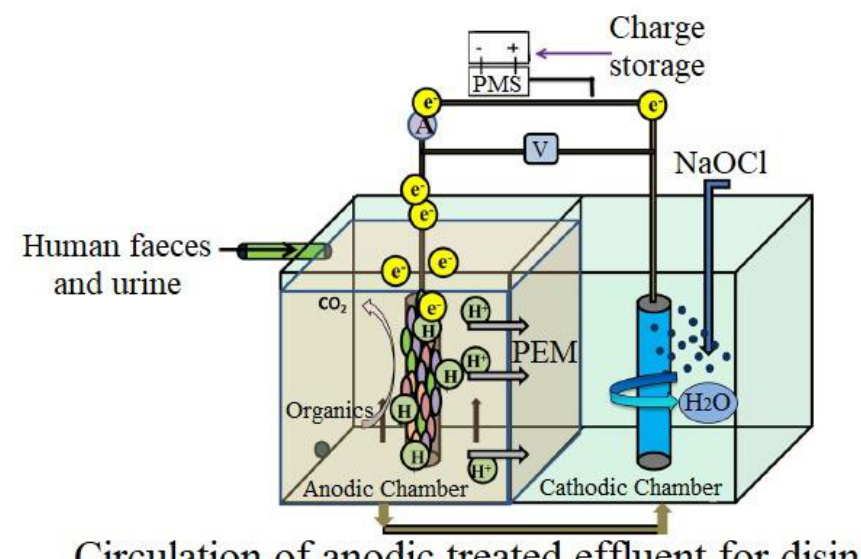
Figure 2. Schematic of human waste-processing microbial fuel cell. Anode chamber is fed with human wastes where different compounds are oxidized by catalytic action of bacteria. In cathode chamber, half-cell reduction takes place.